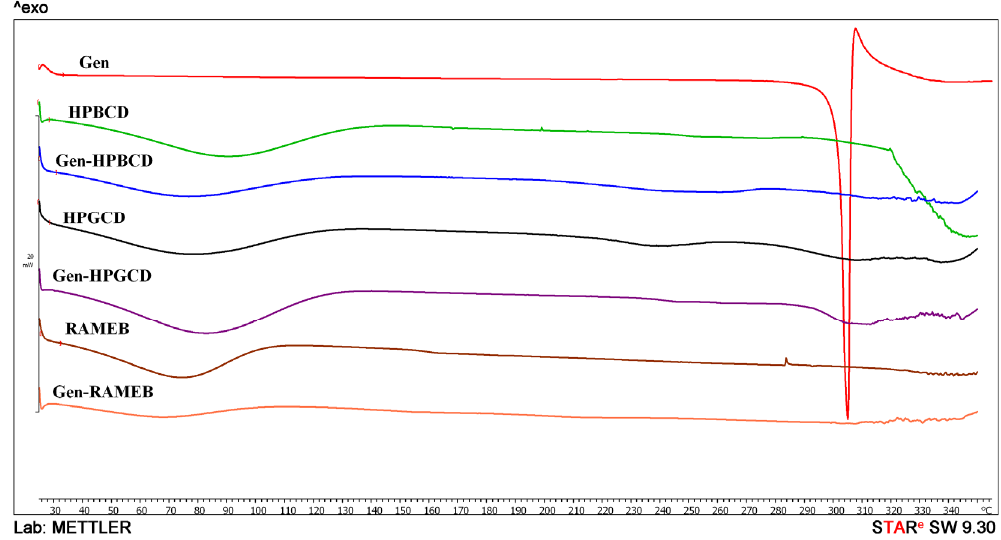
Figure 2. Differential scanning calorimetry (DSC) for Gen; and its’s 1:1 CDs complexes, respectively pure